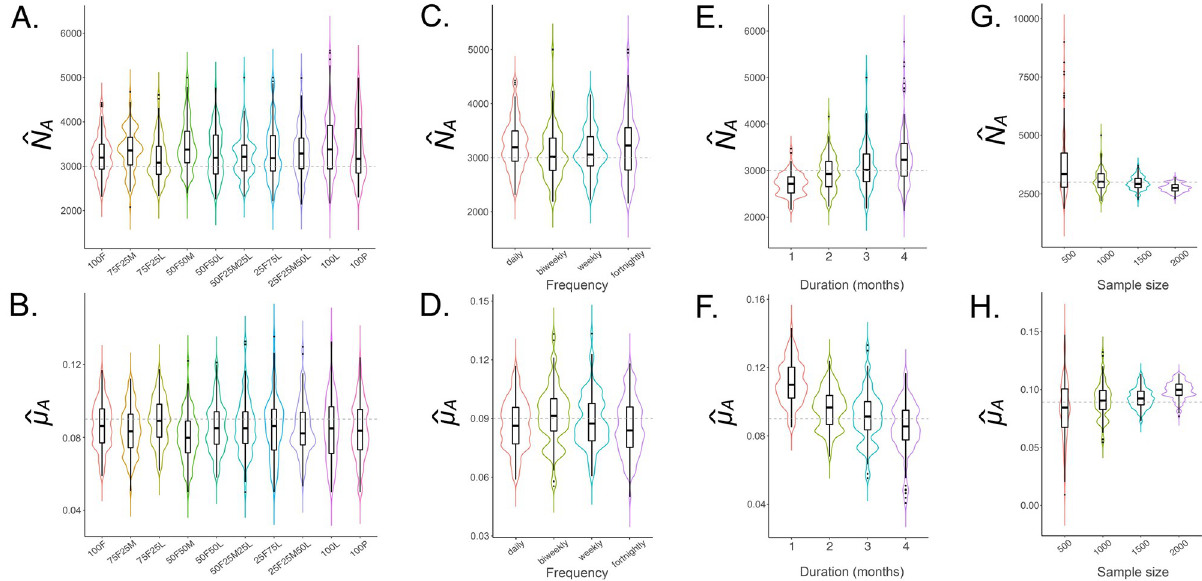
Fig 5. Sampling schemes to estimate N A and μ A for Ae. aegypti . Violin plots depict estimates of N A and μ A for sampling scenarios described in §3.1. The simulated population consists of 3,000 adult Ae. aegypti with bionomic parameters listed in Table 1. Boxes depict median and interquartile ranges of 100 simulation-and-analysis replicates for each scenario, thin lines represent 5% and 95% quantiles, points represent outliers, and kernel density plots are superimposed. The default sampling scheme consists of 1,000 individuals sampled as ca. 11–12 individuals per day over three months. In panels (A-B) , sampled larval, adult female and adult male life stage proportions are varied in 25% increments and limited to scenarios where the number of sampled adult females exceeds the number of sampled adult males (e.g., “75F25M” represents a sample consisting of 75% adult females and 25% adult males, and “50F25M25L” represents a sample consisting of 50% adult females, 25% adult males, and 25% larvae). The case of 100% sampled pupae is also included. In panels (C-D) , all sampled individuals are adult females, and four sampling frequencies are considered—daily, biweekly, weekly and fortnightly. In panels (E-F) , biweekly sampling is adopted, and sampling durations of 1–4 months are explored. In panels (G-H) , a sampling duration of three months is adopted, and total sample sizes of 500, 1,000, 1,500 and 2,000 adult females are explored.